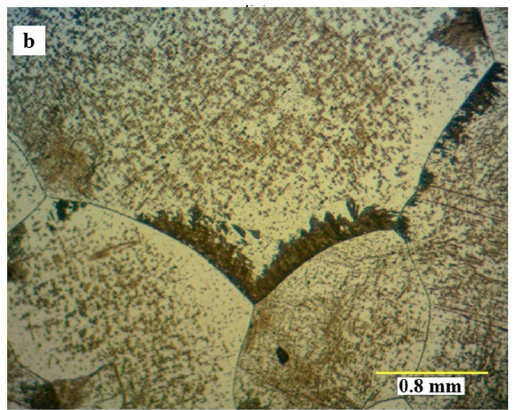
Figure 4. Microstructure of the sample solution treated at 1230 ° C for 3 h, followed by quenching and aging at 850 ° C for ( a ) 24 h and ( b ) 48 h.